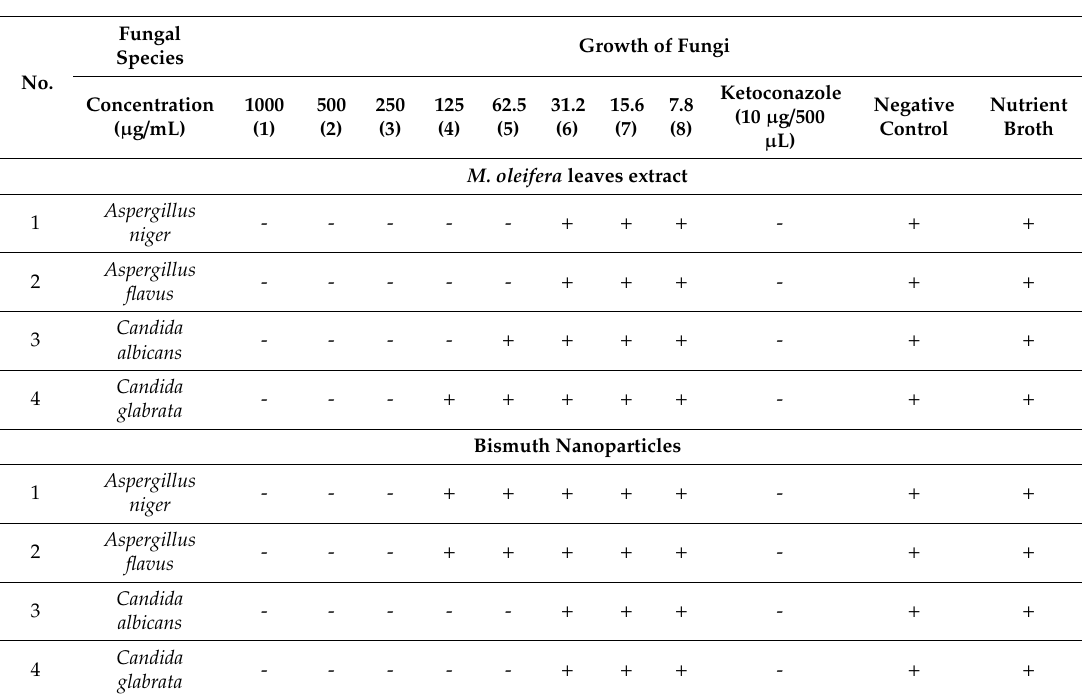
Table 9. Anti-fungal activity data (growth ( + ) and no growth